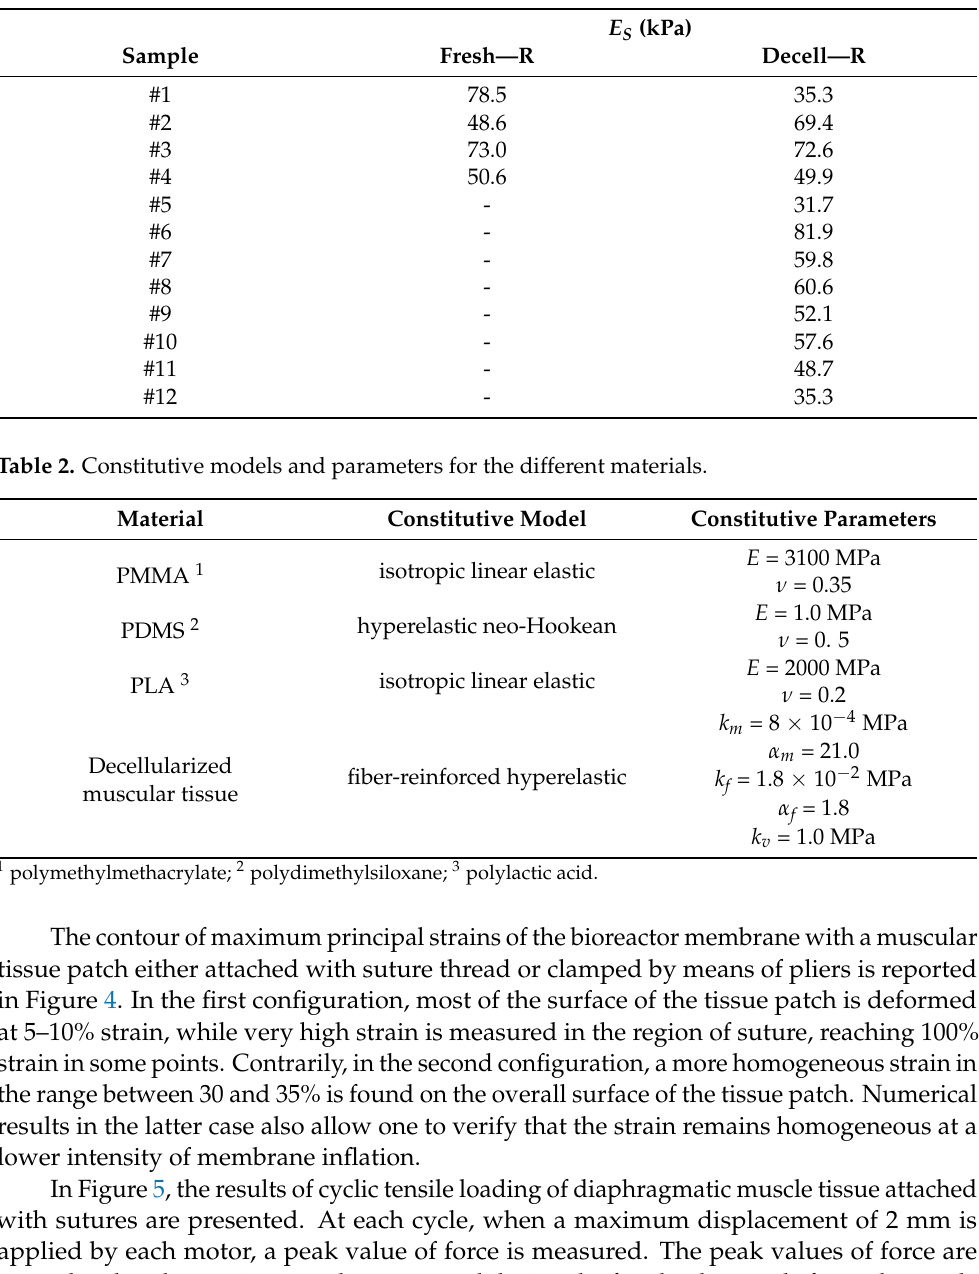
Table 1. Secant elastic modulus E S (kPa) of diaphragmatic muscle tissue at 30% strain in radial (R) direction.